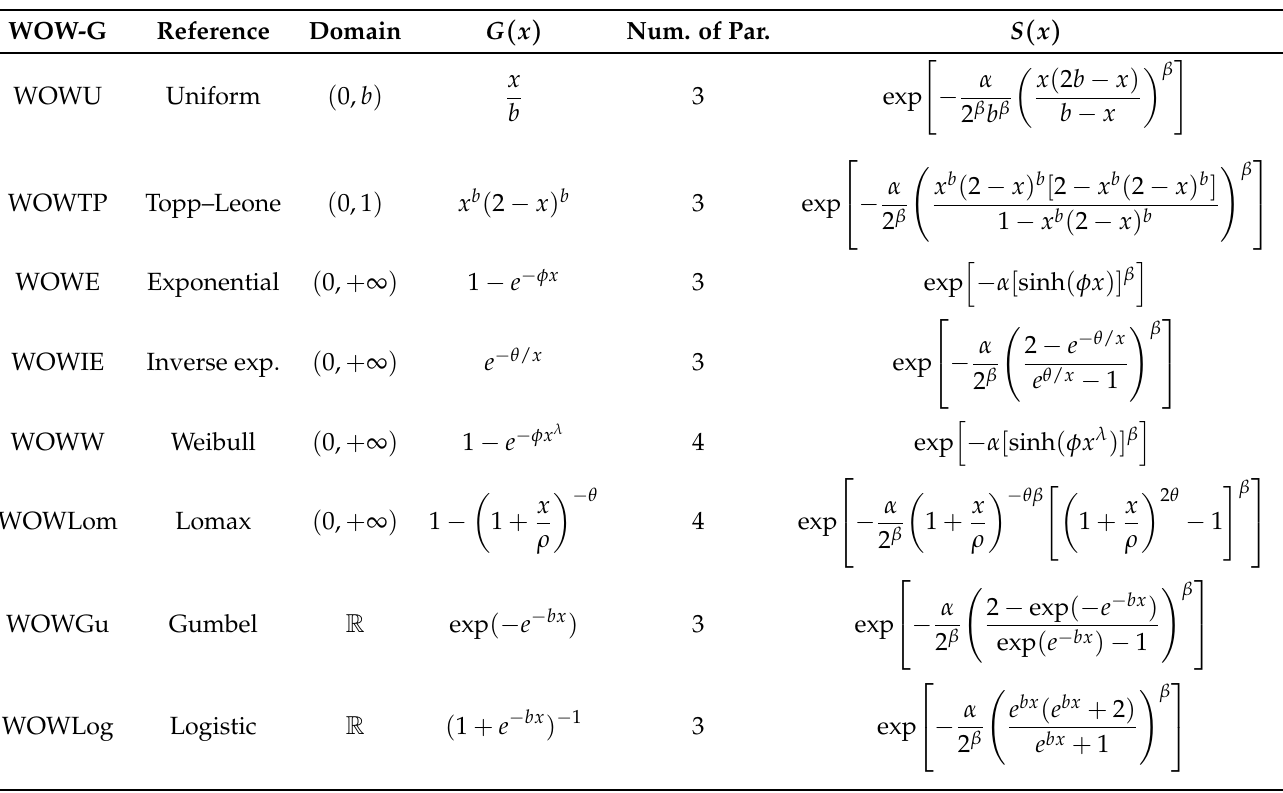
Table 1. Special distributions of the WOW-G class defined from important distributions as